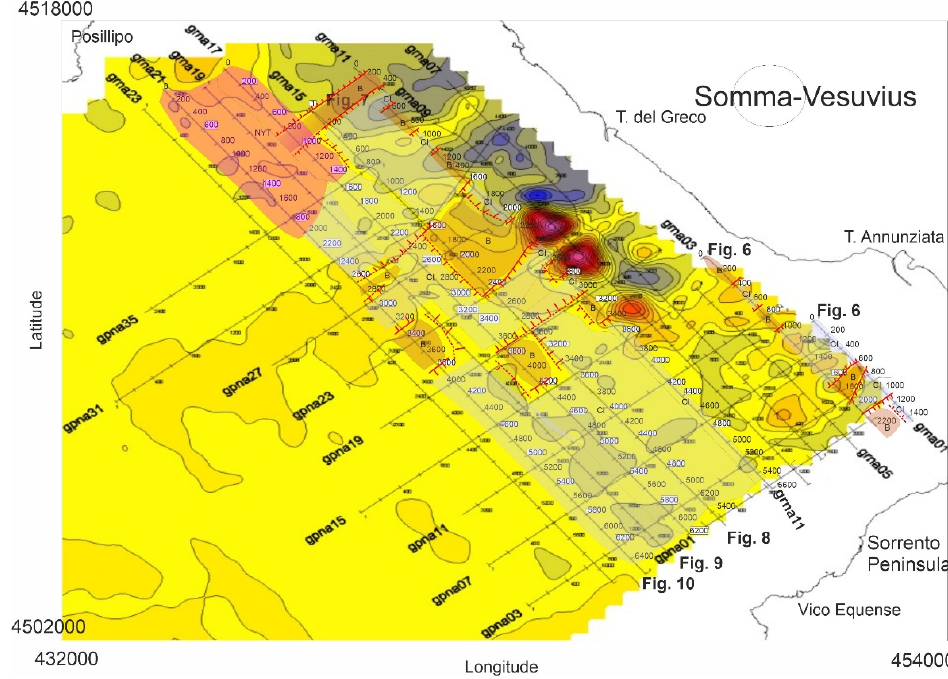
Figure 13. Magnetic map of the eastern Naples Bay and location of the seismic lines with superim- posed A, B, and D seismic and volcanic structures based on this paper.